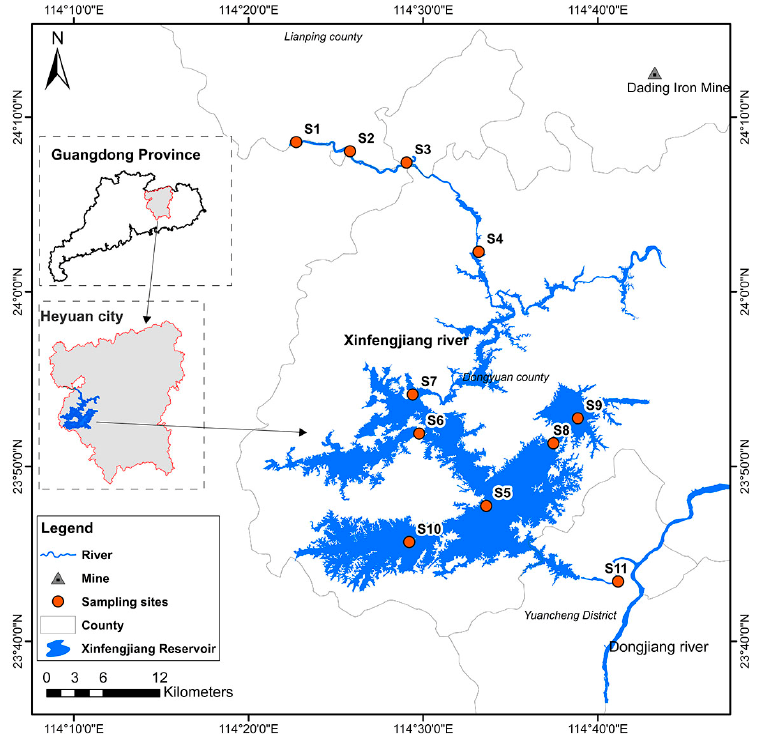
Figure 1. Study area and the location of the sampling sites.